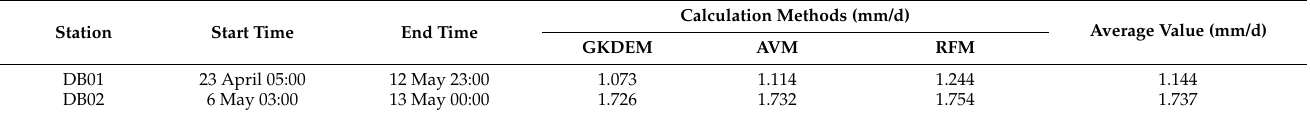
Table 2. The velocity of the two monitoring stations of the Lishanyuan landslide in the CDS.